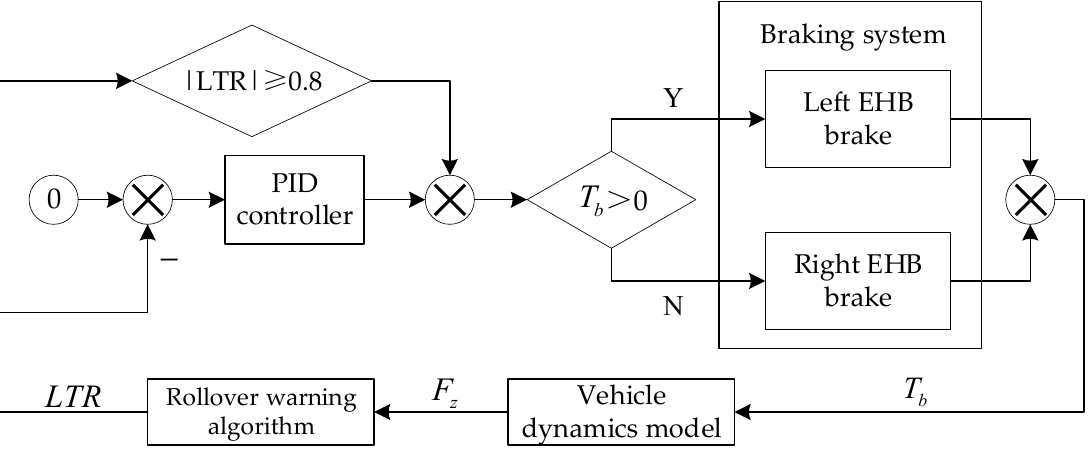
Figure 4. Flow chart of anti-rollover control system.